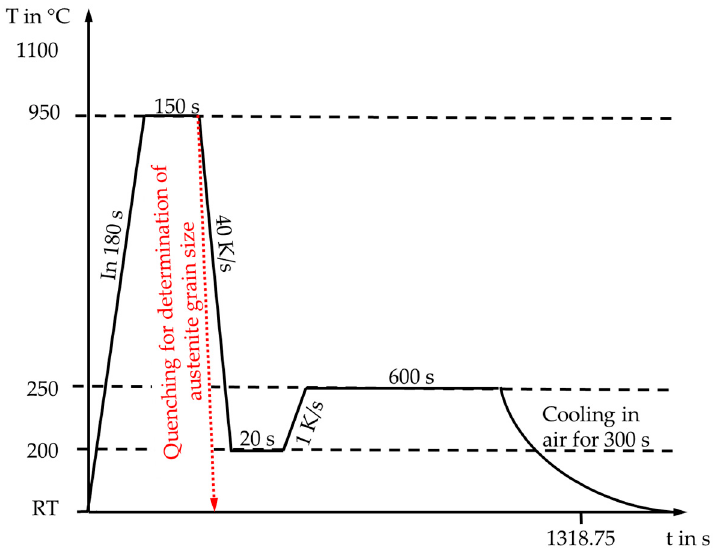
Figure 5. Heat treatment route 1. Q-P-processing route or rapid quenching for determination of austenite grain size.